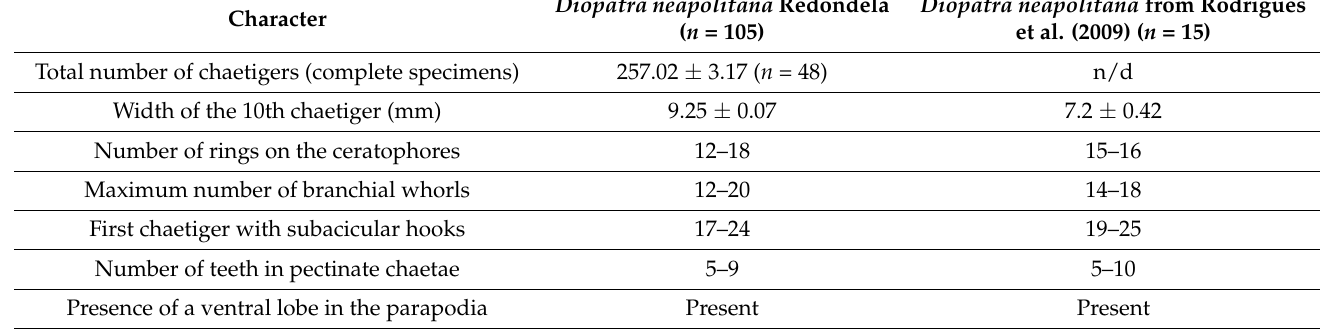
Table 2. Summary of the six diagnostic morphological characters. Average (total number of chaetigers, width of the 10th chaetiger) and range (number of rings on the ceratophores, maximum number of branchial whorls, first chaetiger with subacicular hooks and number of teeth in pectinate chaetae) values obtained in the 105 Diopatra specimens collected in Redondela (NW Spain) during the present work as well as the D. neapolitana specimens from Rodrigues et al. (2009) [12] ( n = 15). The total number of chaetigers of complete specimens is also shown; n/d: not